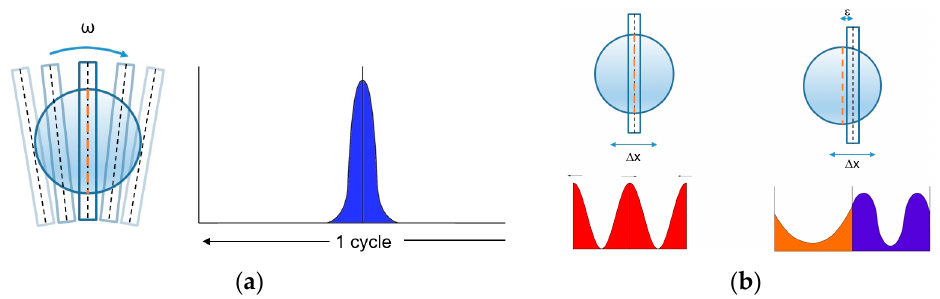
Figure 4. Schematic of the signals (as a function of time): rotating disc ( a ) and oscillating stage ( b ).